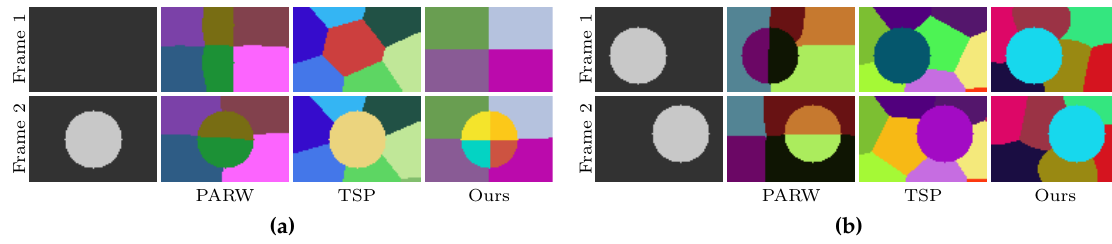
Figure 1. Two toy examples of supervoxel segmentation on ( a ) video with new object and ( b ) video with moving object. The first row are synthetic video frames. The results of two representative state-of-the-art algorithms—PARW [17] and TSP [20]—are plotted in the second and third rows. Our results are shown in the last row. Pixels with the same supervoxel label are painted using the same color, best viewed in